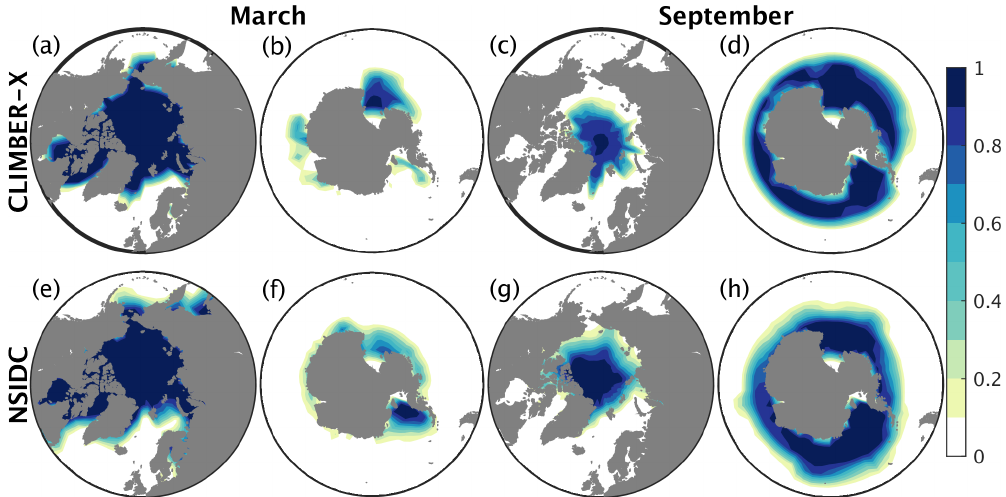
Figure 17. Sea ice concentration in the NH and SH in CLIMBER-X (top) compared to observations (Meier et al., 2021) (bottom) for (left) March and (right) September.